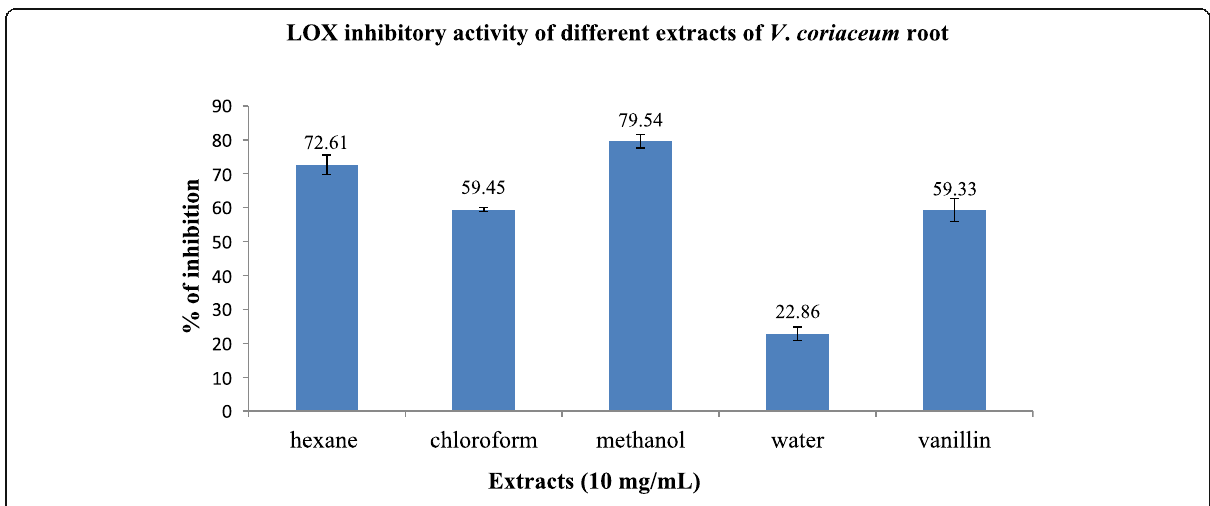
Fig. 6 LOX inhibition showed by different extracts of V .